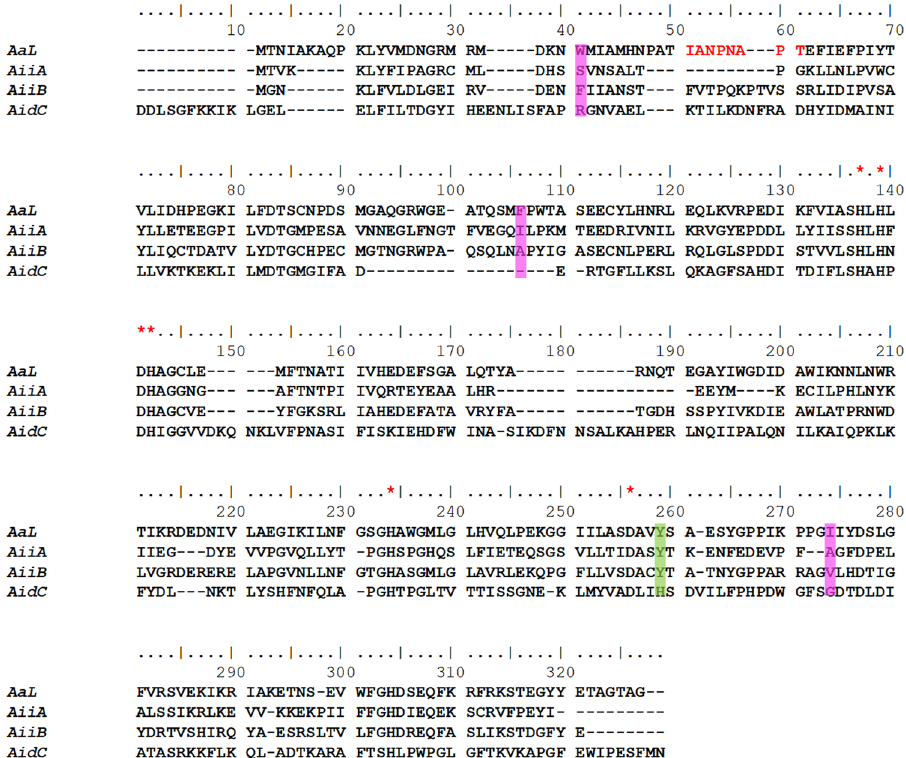
Figure 2. Sequence alignment of the MLLs representatives. Sequence alignment of AaL from Alicyclobacillus acidoterrestris (WP_021296945.1), AiiA from Bacillus thuringiensis (PMC1187999), AiiB from Agrobacterium tumefaciens (WP_010974862.1) and AidC from Chryseobacterium sp. StRB126 (PMC4681436). The residues corresponding to the hydrophobic patch (W26, F87 and I237) identified in AaL are highlighted in pink and the amino acids involved the metal coordination (including the characteristic HXHXDH motif) are designated by a red star. The position highlighted in green (Y223 in AaL) corresponds to a tyrosine residue possibly involved in the catalytic mechanism. The amino acids in red are involved in the dimerization of AaL.